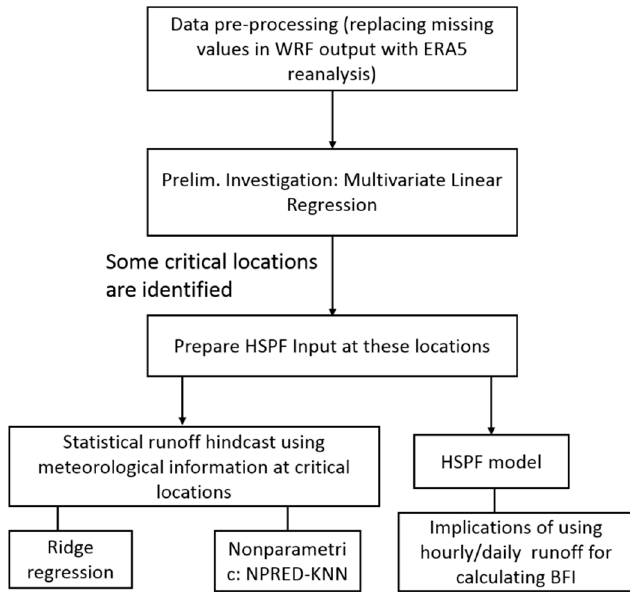
Figure 2. Flowchart of methodologies.